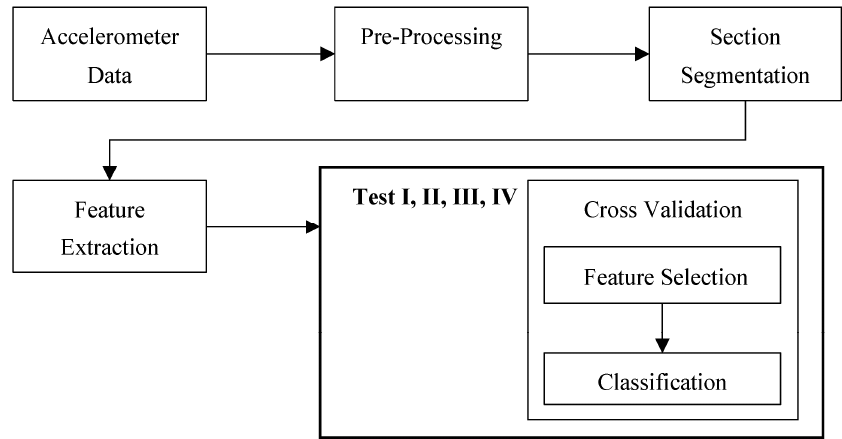
Figure 4. Overview of data processing and classification process.